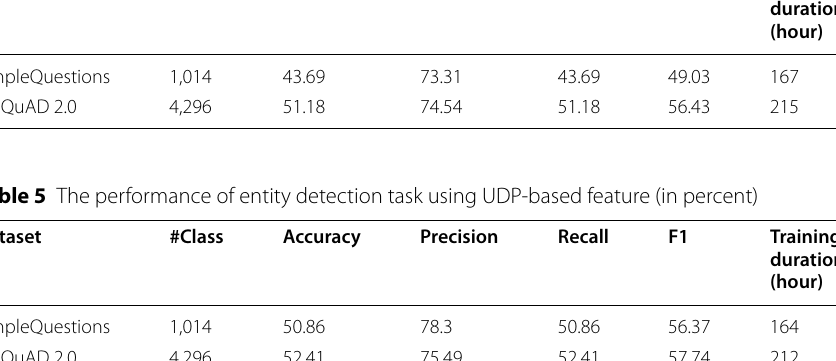
Table 3 The performance of entity detection task using text-based feature (in percent) Dataset #Class Accuracy Precision Recall F1 Training SimpleQuestions 1,014 99.15 164 LC-QuAD 2.0 211